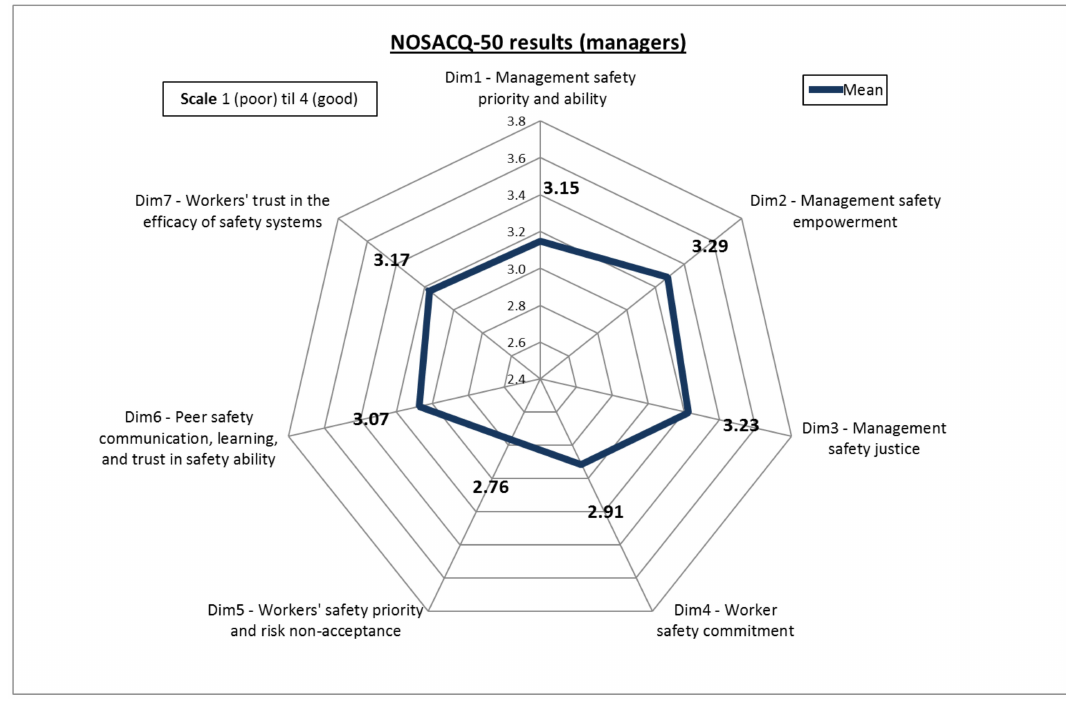
Figure 3. Overall scores obtained by